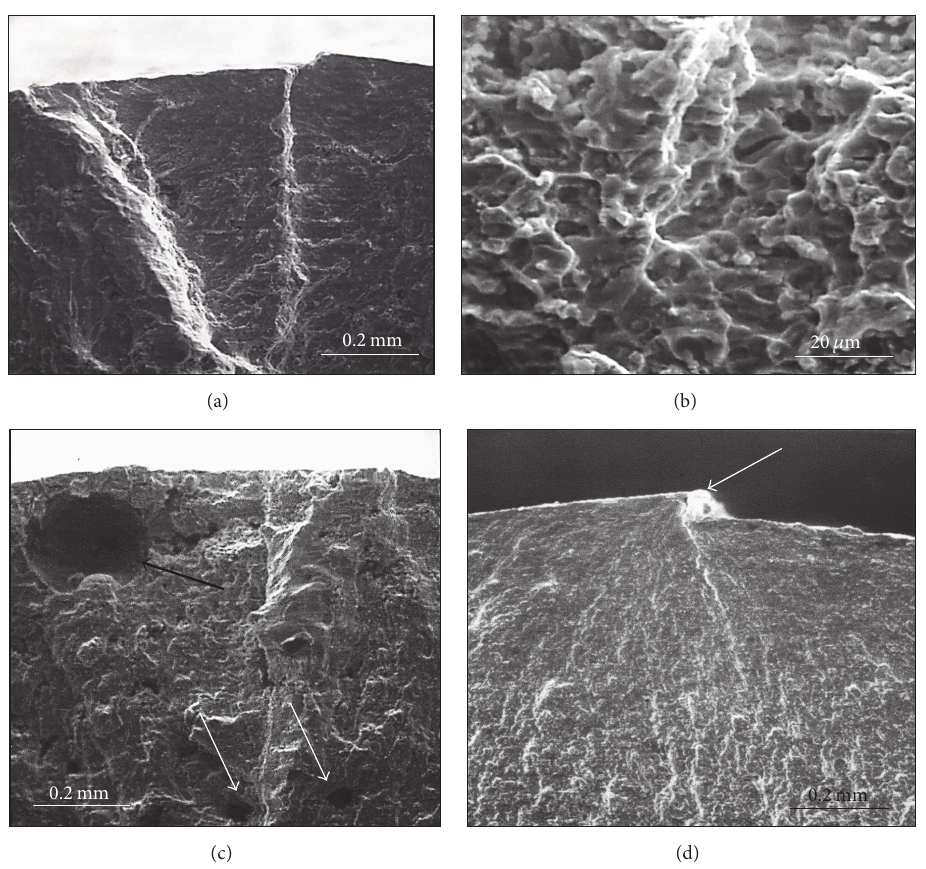
Figure 16: Fracture surfaces of DCM5 fatigue samples: (a, b, and d) after casting and (c) after aging at 220 ∘ C for 25 h.